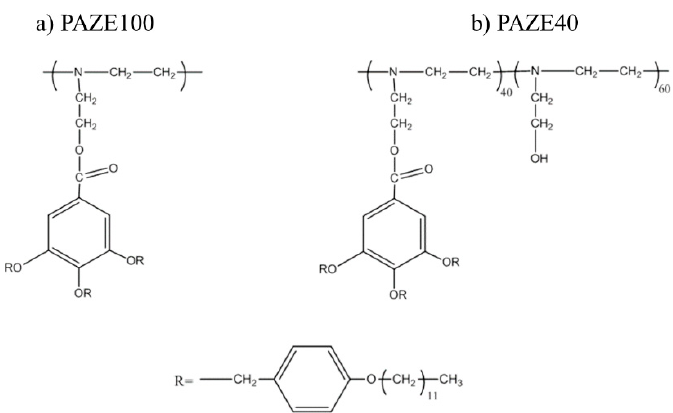
Figure 1. Structures of poly[2-(aziridin-1-yl) ethanol] (PAZE) polymer and copolymer.